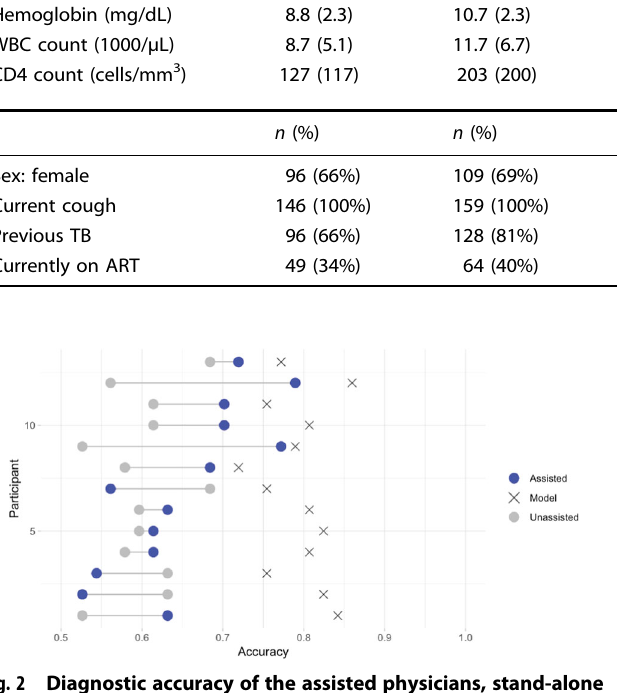
algorithm performance under different training strategies is detailed in Table 2.